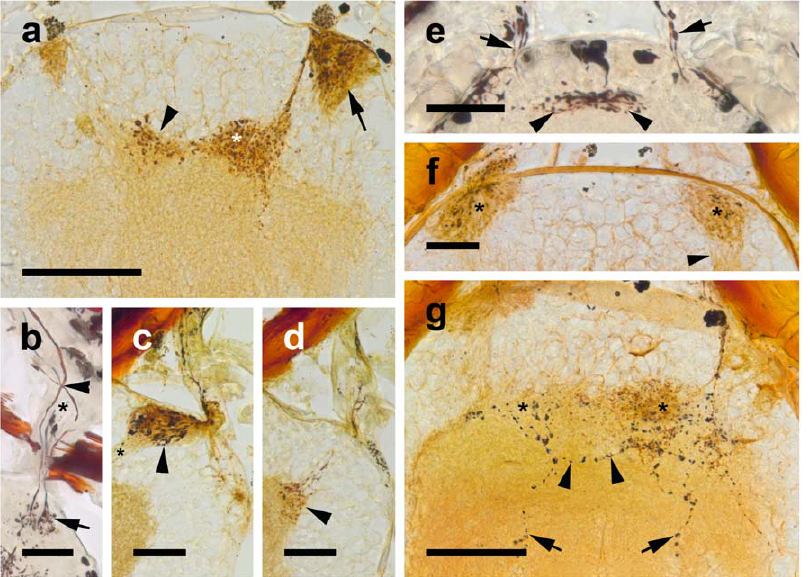
Figure 3. Neuroanatomy of the visual neuropils revealed with cobalt backfills (a, c, d, f, g) and Golgi technique (b, e). a , b , Achelia langi ; c – e , Achelia vulgaris ; f , g , Endeis spinosa . In a and g cobalt backfills of two sections are combined. a , First (arrow) and second (asterisk) visual neuropil identified with cobalt backfills, transversal section. Note dense arrangement of cobalt filled profiles in both neuropil pairs. Arrowhead points to a few axons of the right retinula cells that send axon collaterals to the contralateral, left neuropil. Bar 50 m m. b , Retinula axons projecting from dorsal through dorsolateral thickening (asterisk) into first visual neuropil (arrow) where they form short collaterals and synaptic varicosities; note re- assortment of single axons (arrowhead), transversal section. Bar 25 m m. c , d , Retinula axon terminals in first ( c ) and second ( d ) visual neuropil, with synaptic varicosities in both neuropils (arrowheads); in c a tract connects first visual neuropil with protocerebrum (asterisk); sagittal sections. Bars 25 m m. e , Retinula axons (arrows) and second visual neuropils (arrowheads), transversal section. Bar 25 m m. f , g , Cobalt backfills of retinula axons terminating in first ( e ) and second ( f ) visual neuropils (asterisks); in f a tract connects first visual neuropil with protocerebrum (arrowhead); in g a fibre connecting ipsi- and contralateral second neuropil is seen (arrowheads), note a single fibre per brain hemisphere that travels through second visual neuropil and terminates deeper in protocerebrum (arrows); transversal sections. Bar 50 m m.